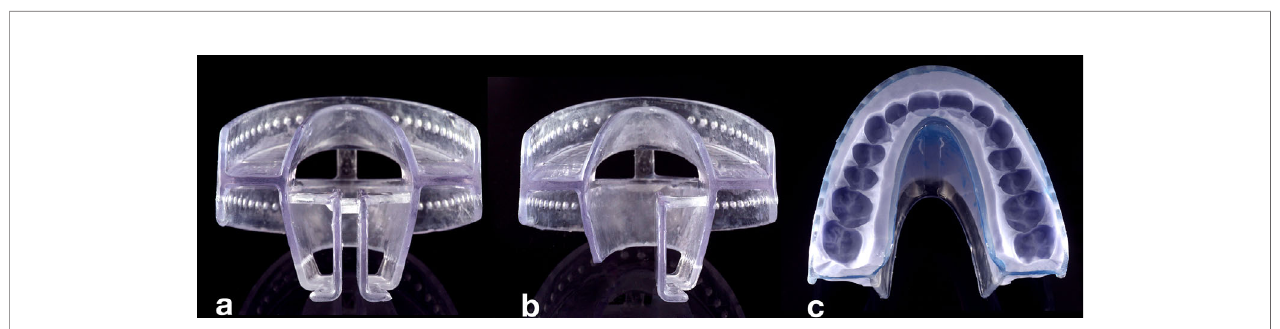
FIGURE 2 | View of a pre-fabricated TRD. After size selection, different tongue displacements can be realized by removal of tongue retraction parts (TPs). (A) If no parts are removed, caudal tongue displacement can be achieved. (B) The left part of the TP was removed along de fi ned breaking points enabling tongue